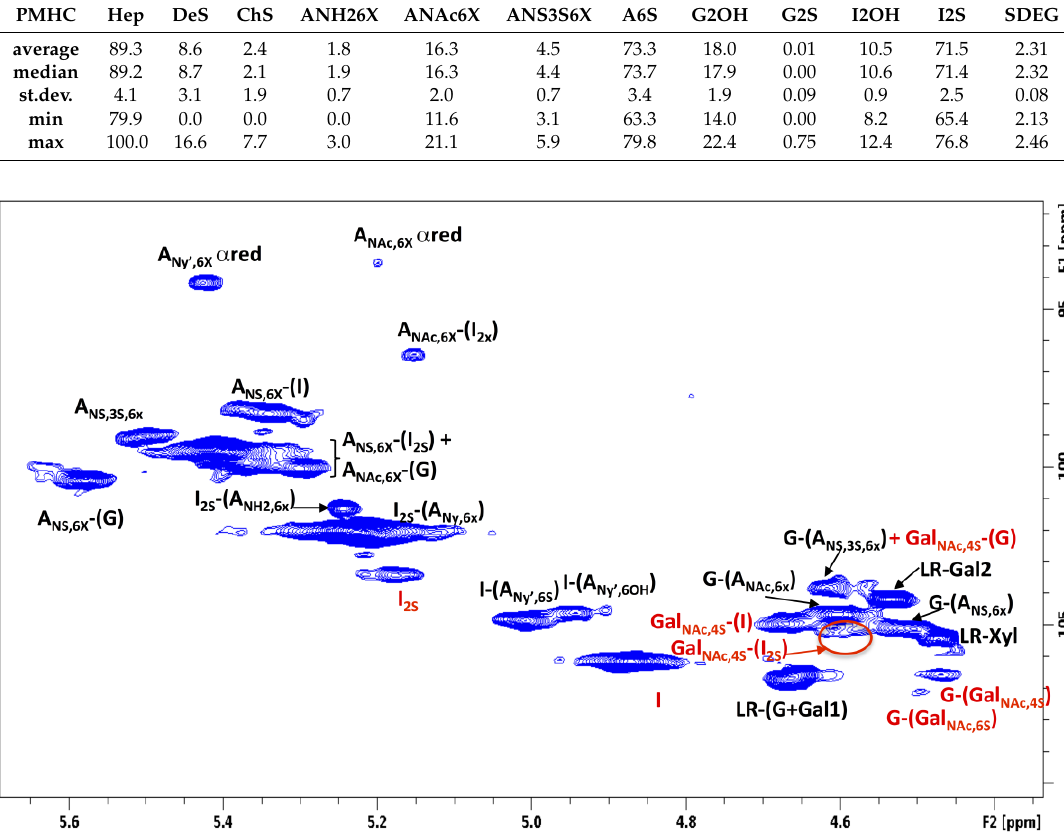
Figure 6. Anomeric region of a crude heparin HSQC spectrum. Signal assignments of heparin and DeS/ChS components are in black and red, respectively.